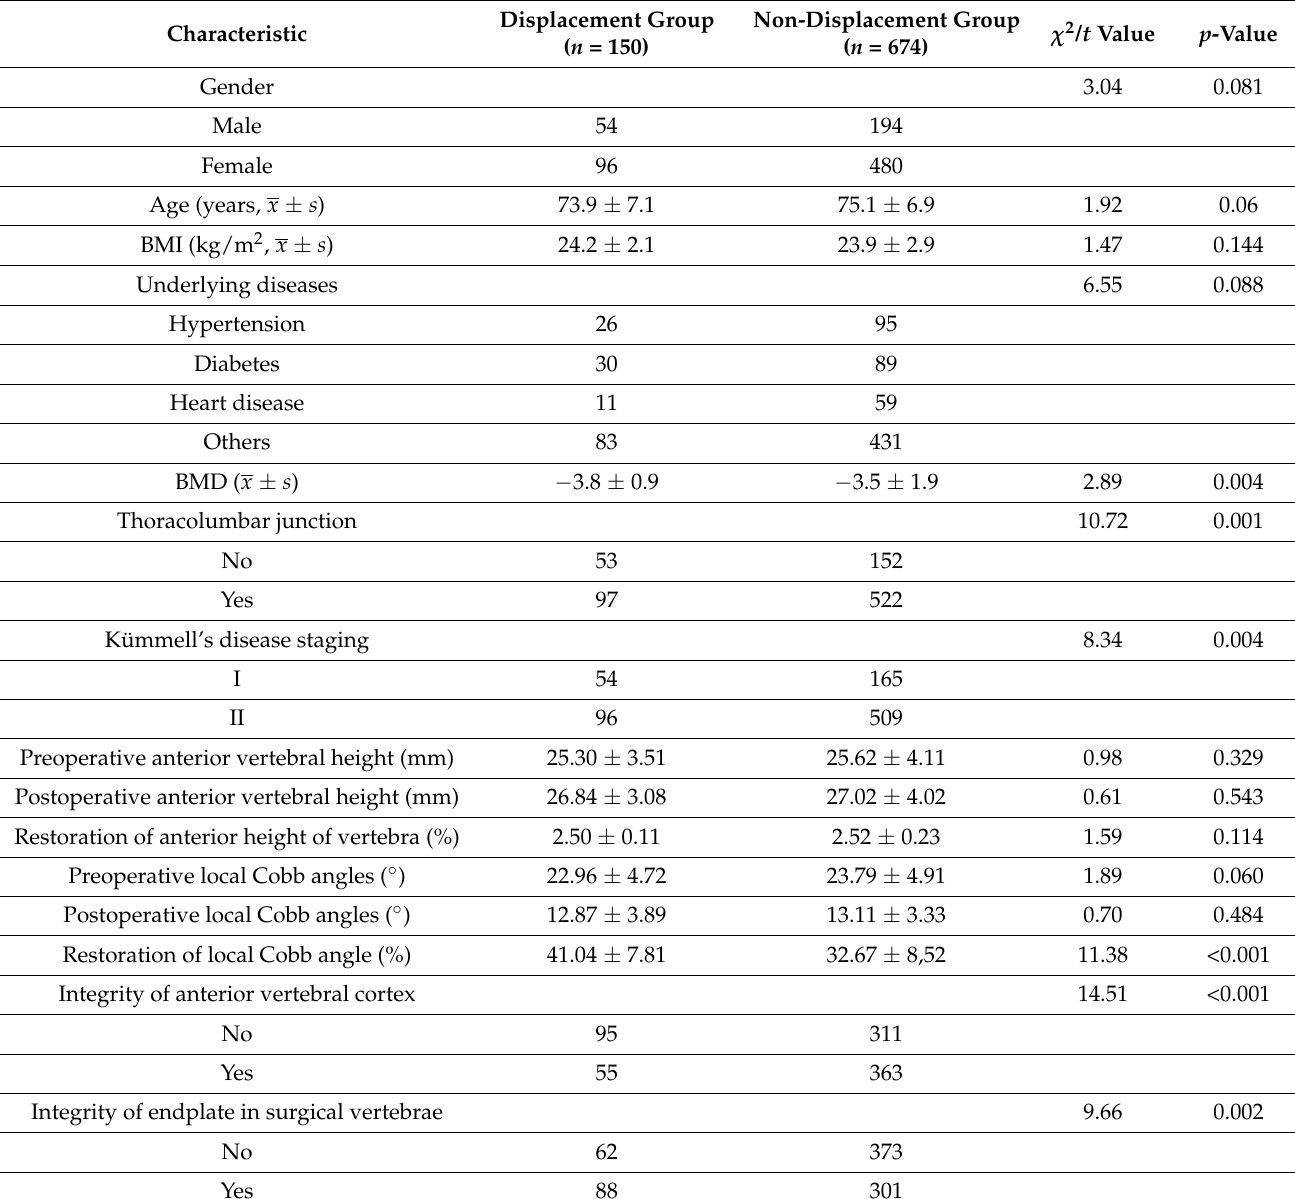
Table 2. Univariate analysis of postoperative bone cement displacement following PVA in Kümmell’s